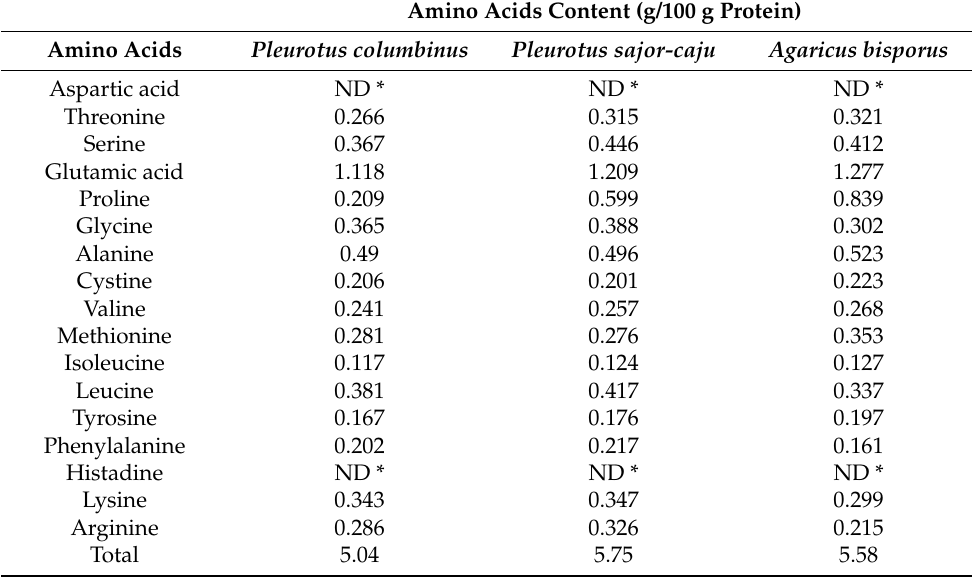
Table 4. Amino acids composition in three mushroom